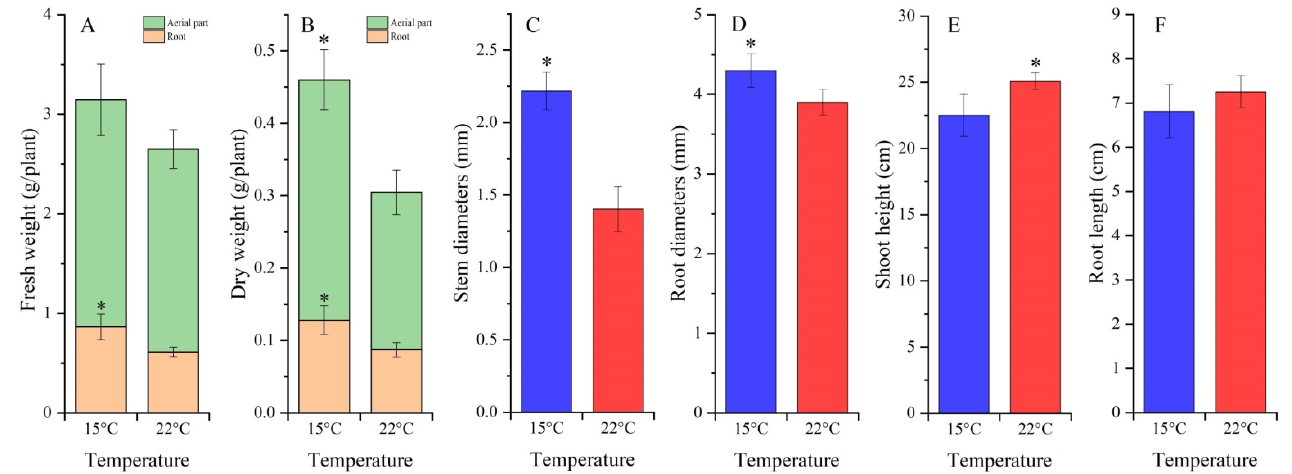
Figure 2. Growth characteristics in A. sinensis treated with cool temperature (mean ± SD, n = 20). Images ( A , B ) represent the FW and DW of the entire plant, ( C , D ) represent the stem and root diameters and ( E , F ) represent the shoot height and root length. “*” represents a significant difference ( p < 0.05) at different stages. The same below.